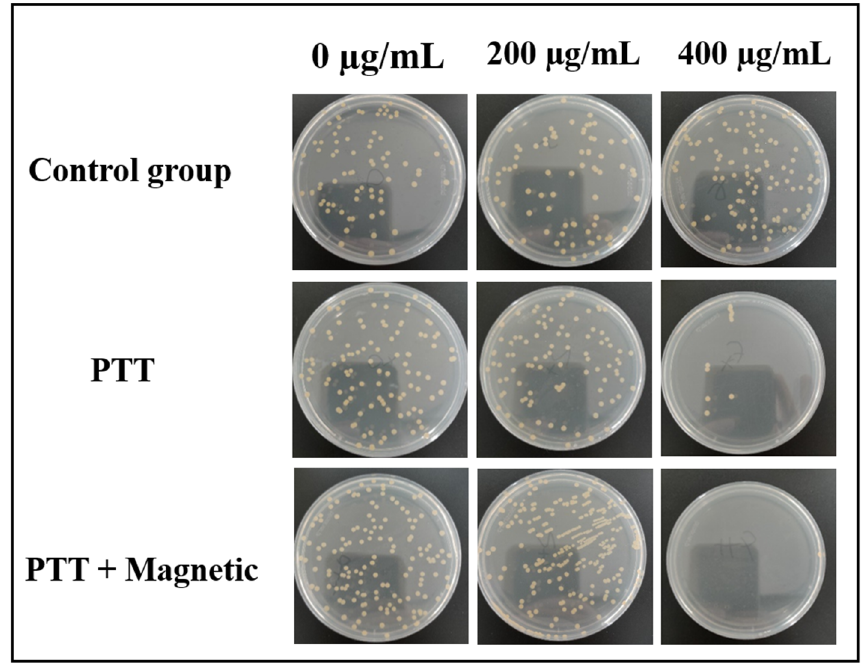
Figure 10. Co-culture results of Fe 3 O 4 @SiO 2 @Au/PDA nanochains against Staphylococcus aureus in different concentrations under different conditions.